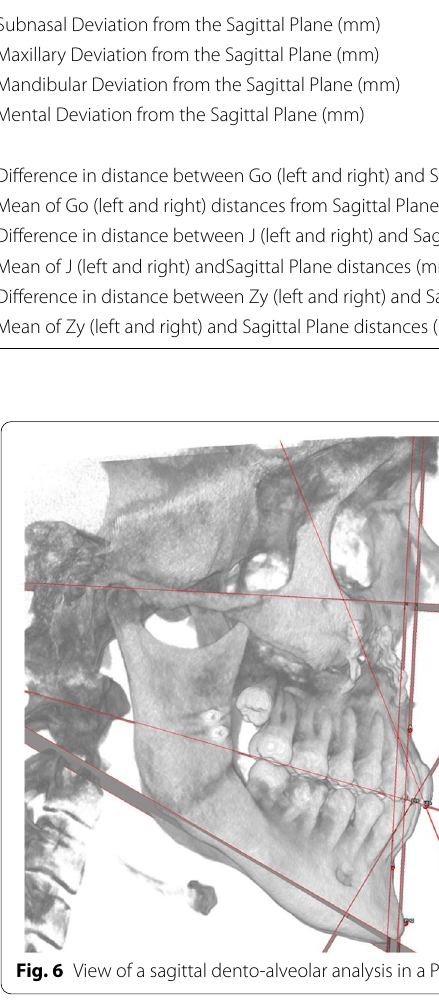
Table 5 Frontal skeletal analysis: frontal parameters and symmetry values Strictly frontal parameters